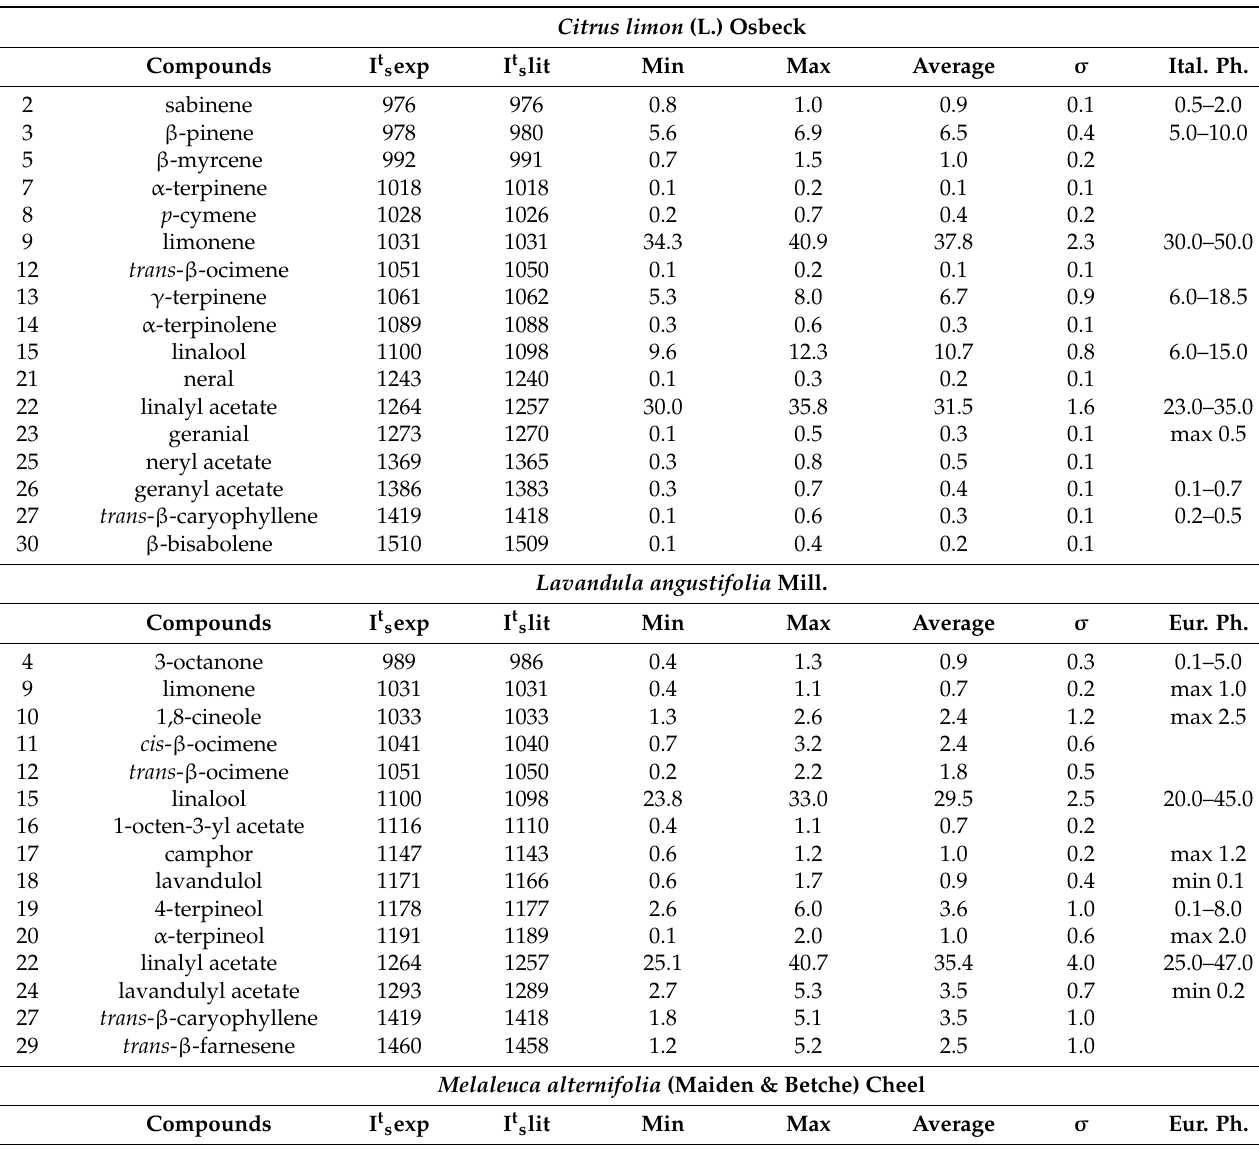
Table 1. Normalised relative abundance (minimum, maximum and average normalised % area) of the marker compounds in bergamot, lavender and tea tree essential oils (number of samples: 20). Citrus limon (L.)